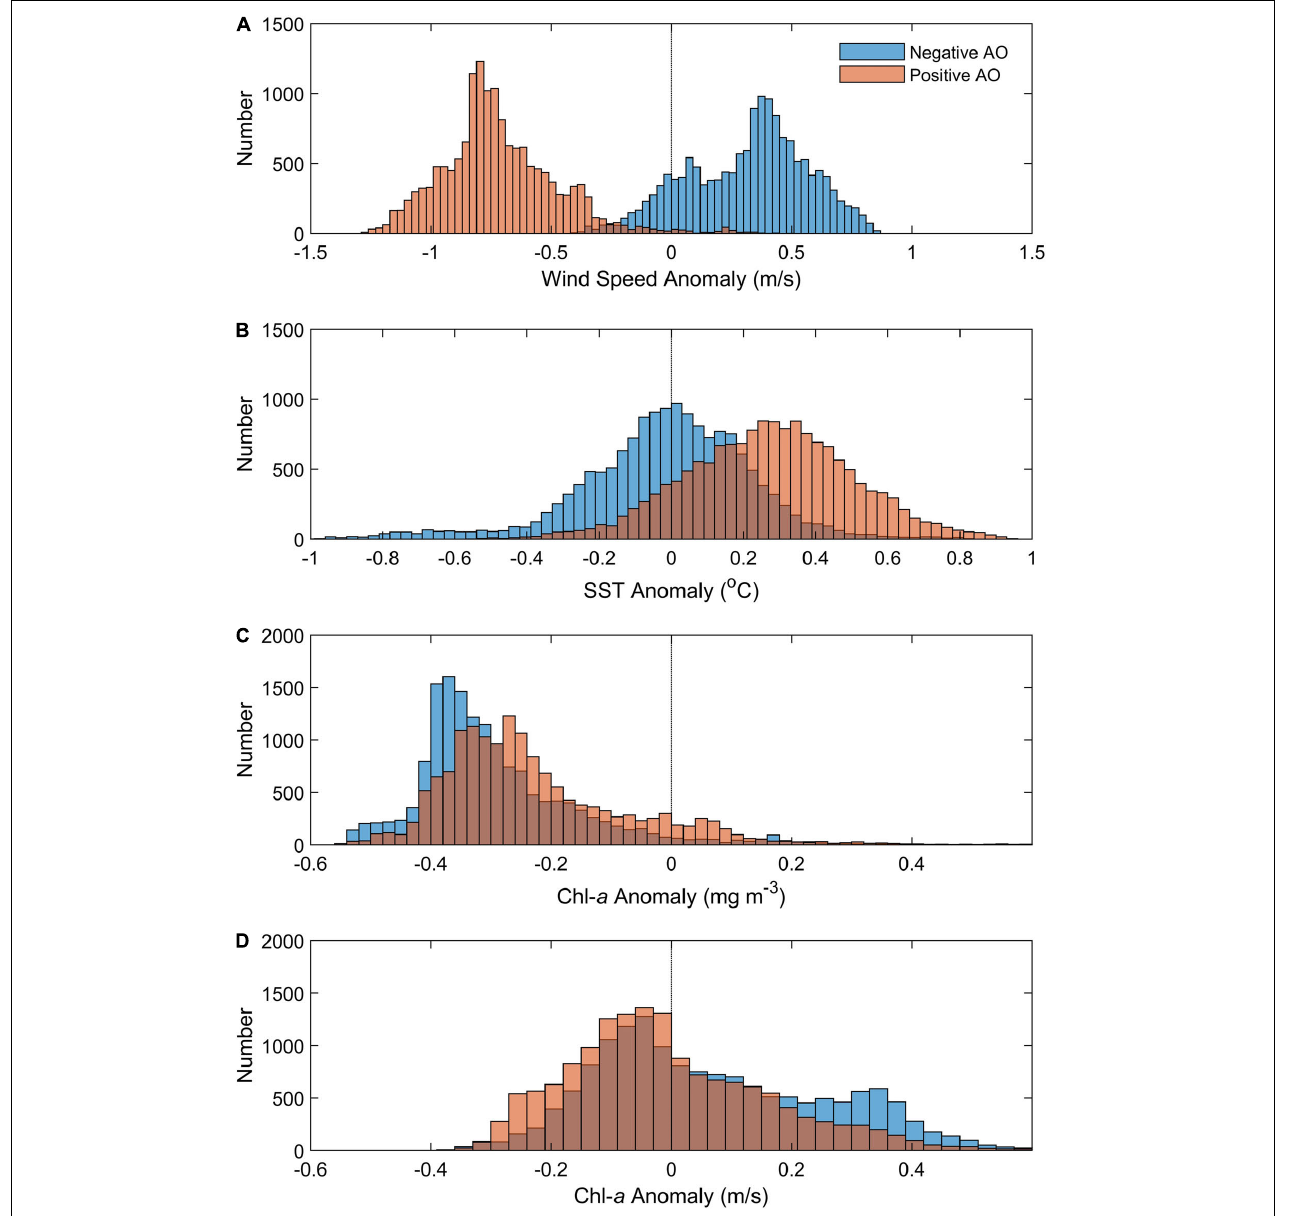
FIGURE 11 | Histogram of the (A) wind speed anomaly, (B) sea surface temperature (SST) anomaly, and (C) chlorophyll- a concentration (Chl- a ) anomaly averaged over the periods of the positive AO index ( > 1) in winter (December, January, and February) and (D) Chl- a anomaly in spring